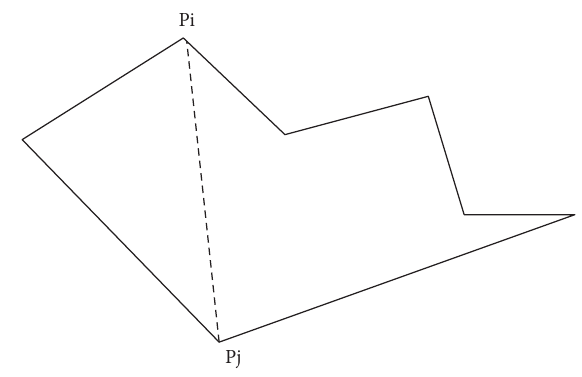
Figure 2: Schematic diagram of triangulation